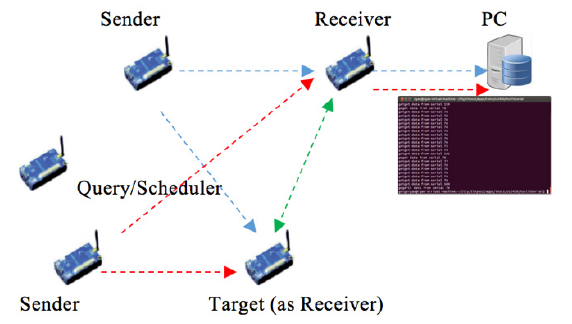
Fig. 12. Scheme of Communication in Z1 Sensor